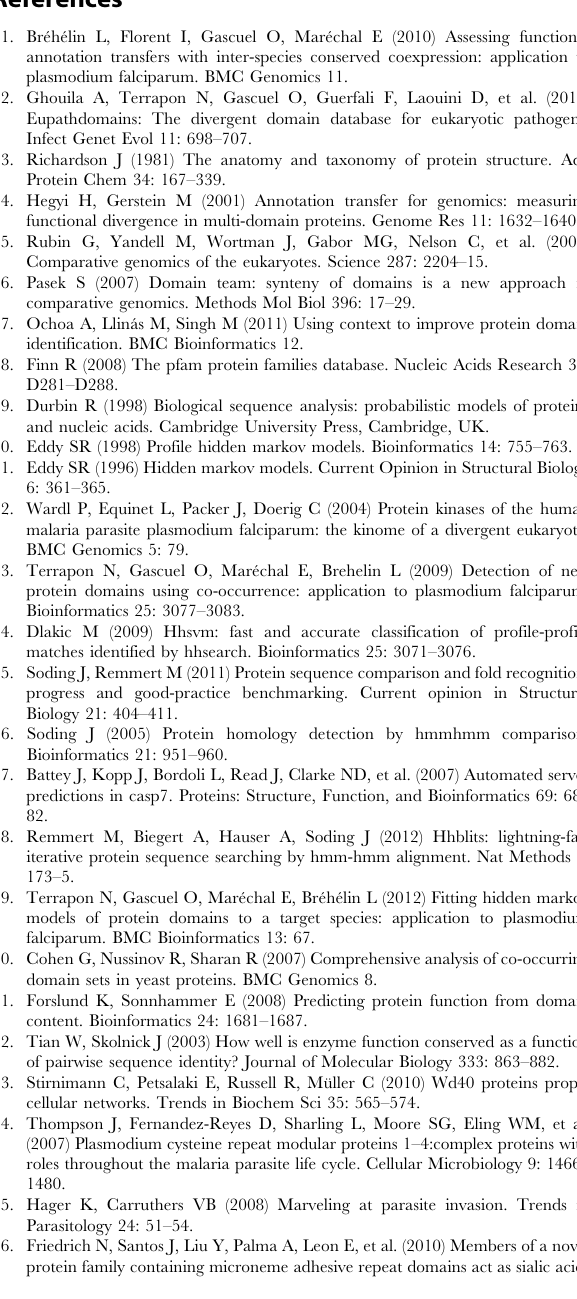
new domains (x-axis) certified by HHPRED + CODD (in orange and green for the phylum specific and non-specific approaches, respectively) and HMMER + CODD (blue) using local (left) and global (right) alignments for various FDR thresholds (y- axis). Table S1 List of considered associations between domains and GO terms. Table S2 List of the 36 P. falciparum domain predic- tions that were manually analysed.